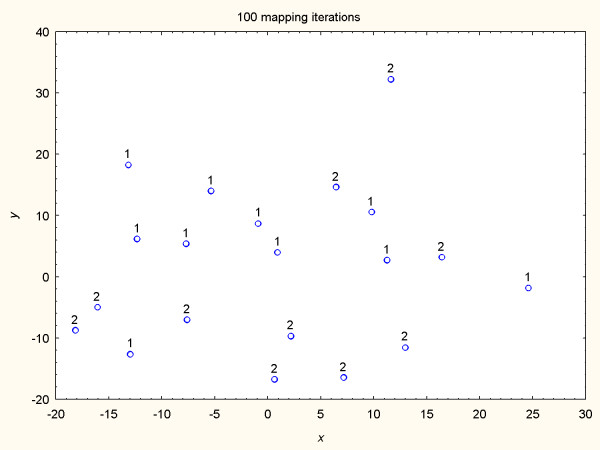
Relaxation non-linear mapping of the Parkinson's disease model data. Parkinson's disease and Normal samples are identified by symbols '1' and '2' respectively. 100 mapping iterations.